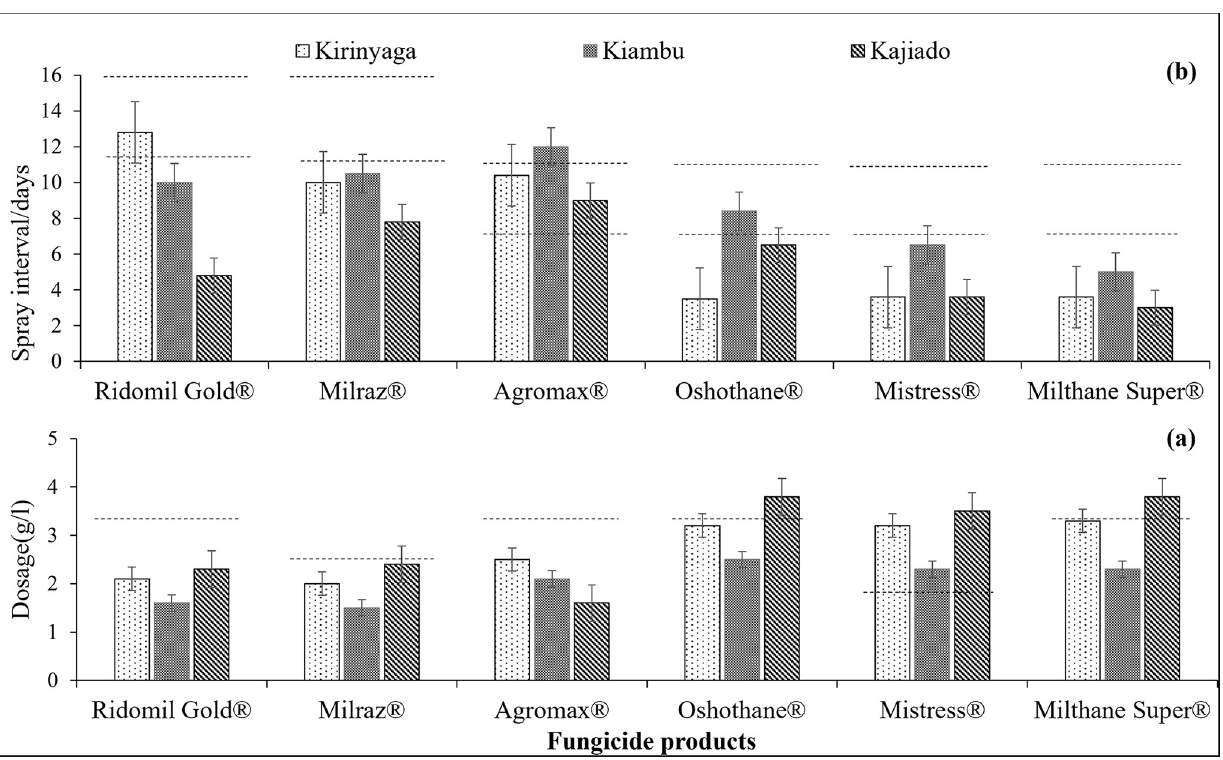
Fig 3. Farmer’s application rates for 6 most commonly used fungicide products against Early blight relative to manufacturer’s recommended levels (indicated by dotted lines) (a) Average farmers’ spray dosages (b) Average farmers’ spray intervals. Farmers’ dosages were calculated from responses on